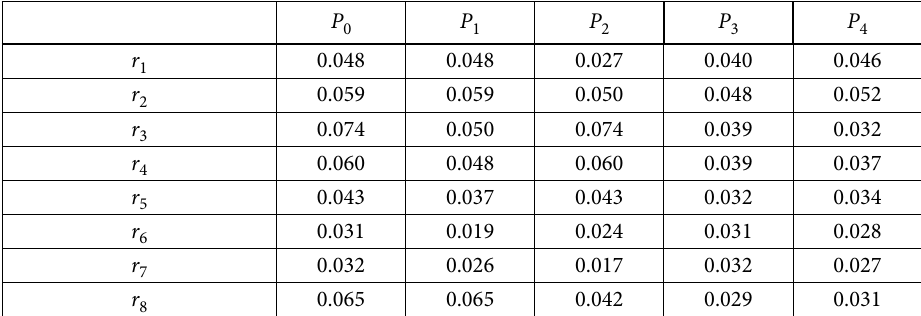
Table 8. Overall performance degree of organization of weighted evaluation